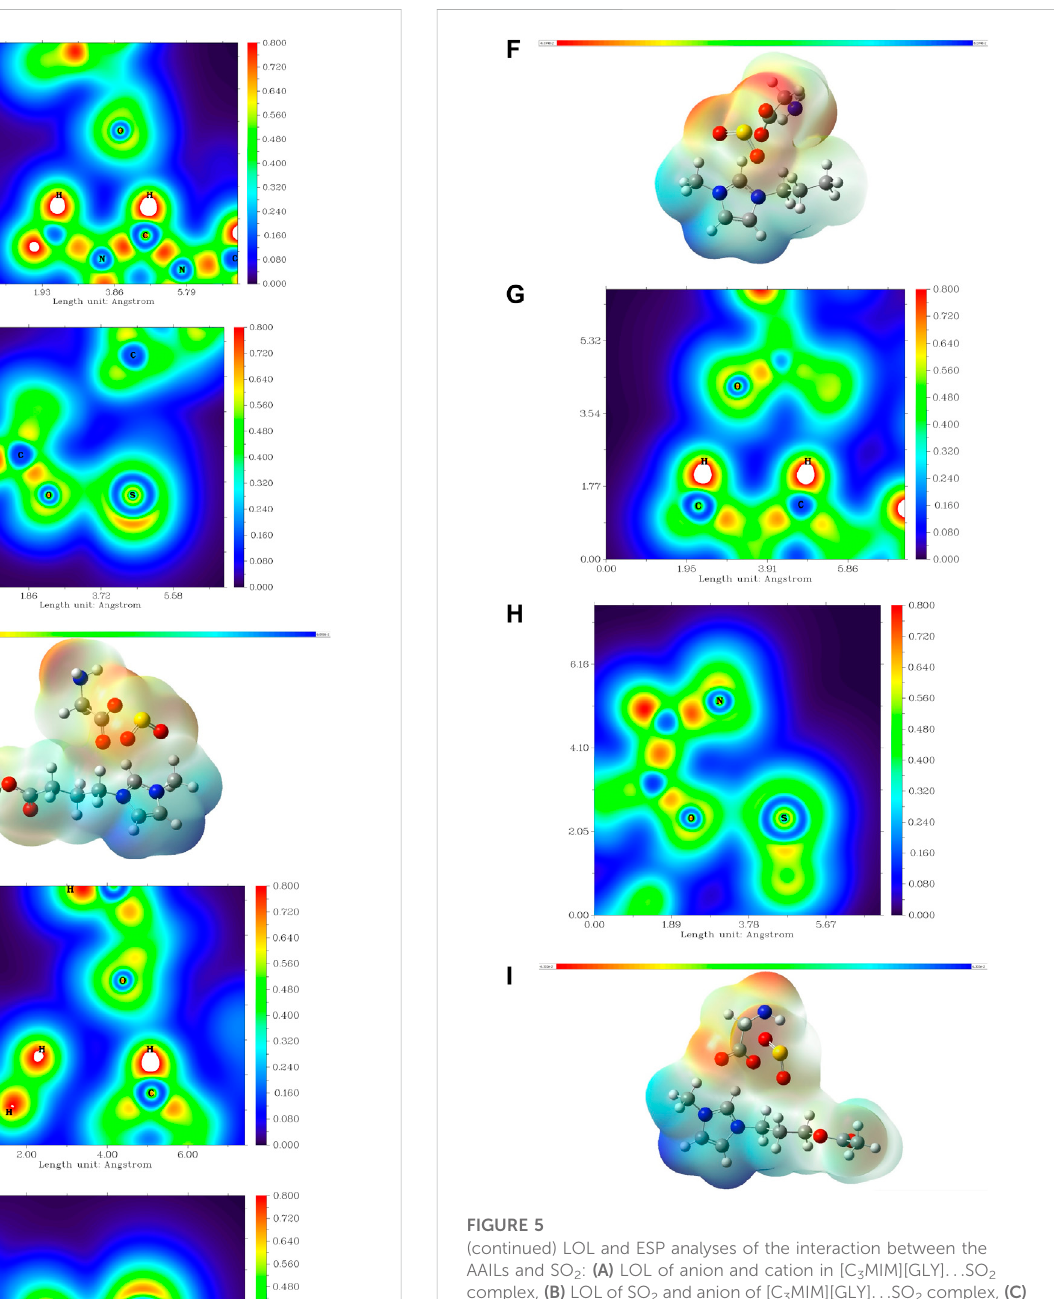
through charge transfer of SO 2 ··· anion elucidating that the complex has a good ability to absorb SO 2 gas. To evaluate charge transfer in these complexes, atomic site charges were obtained by using the NBO method in the gas phase. The charge of the SO 2 gas after absorption is negative con fi rming the charge transfer from the AAIL to the gas. Based on Figure 3, there is a direct relationship between BE and Δ q SO ; as a consequence, gas dissolution in the AAIL has 2 enthalpic nature (Mondal and Balasubramanian, 2016).